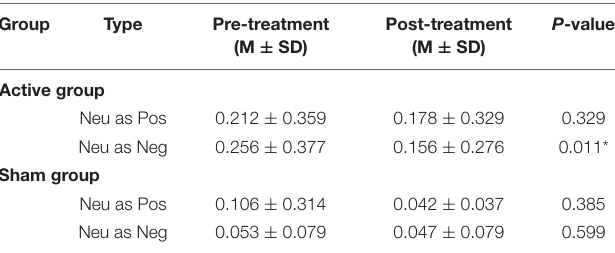
TABLE 2 | The commission errors rates of neutral standards between pre- and post-treatment test in two groups.